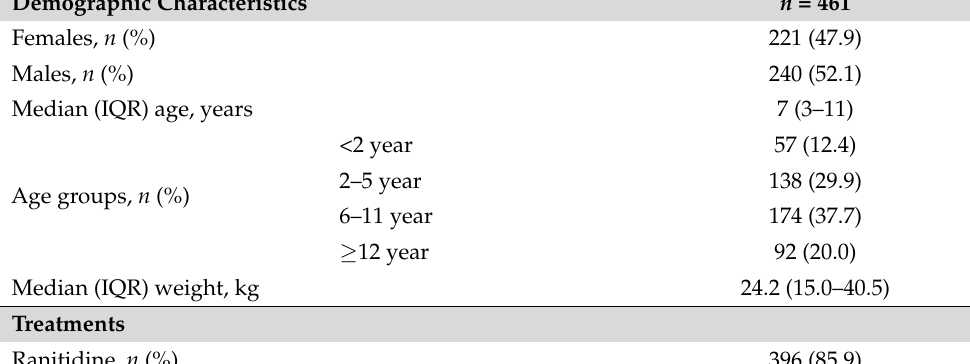
Table 1. Demographic, clinical and treatment characteristics of the study population. Demographic